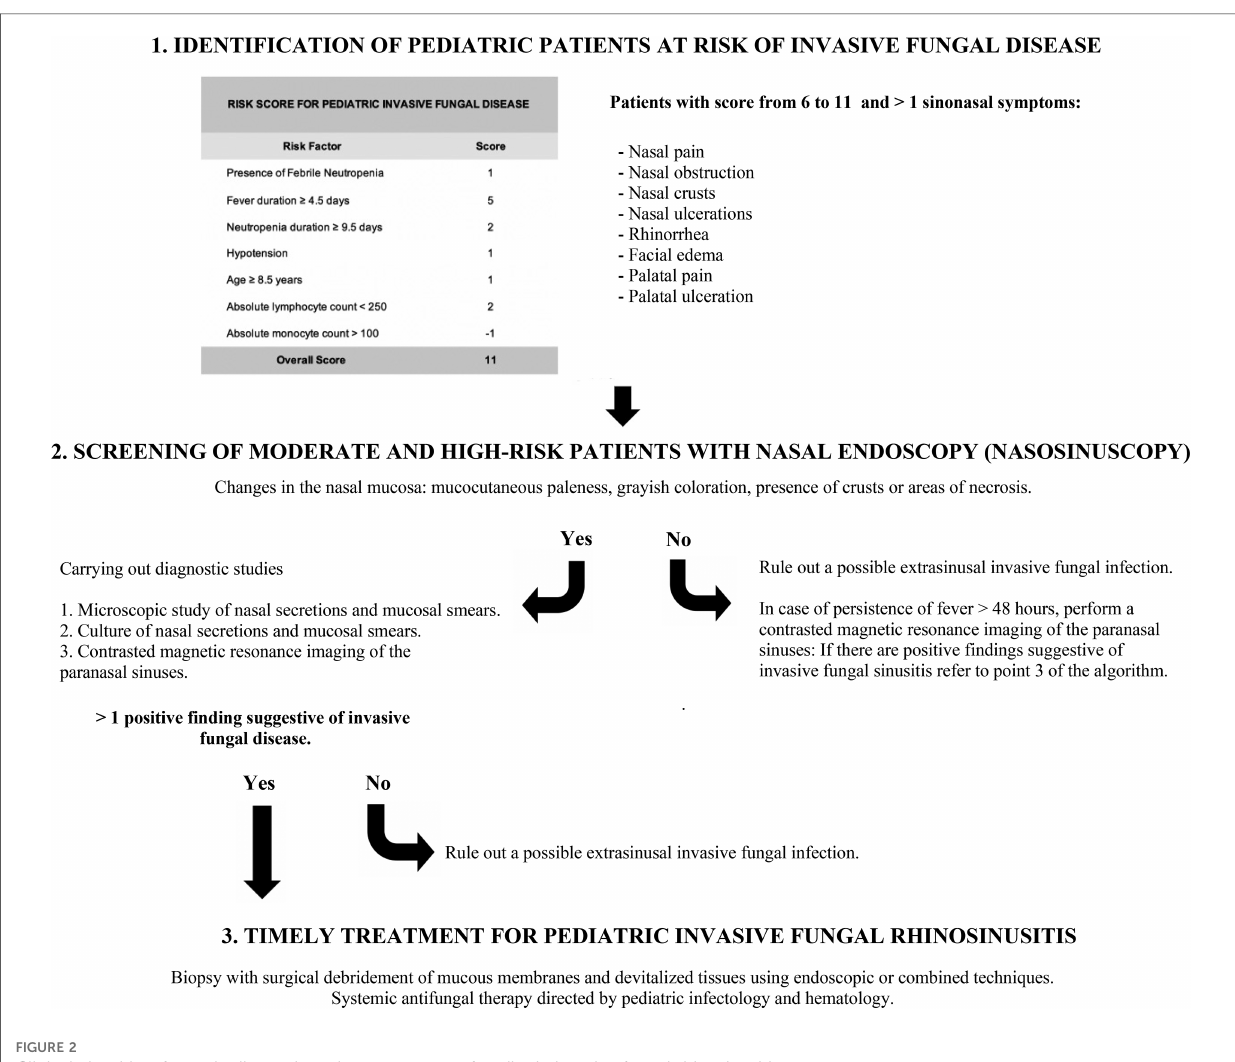
FIGURE 2 Clinical algorithm for early diagnosis and management of pediatric invasive fungal